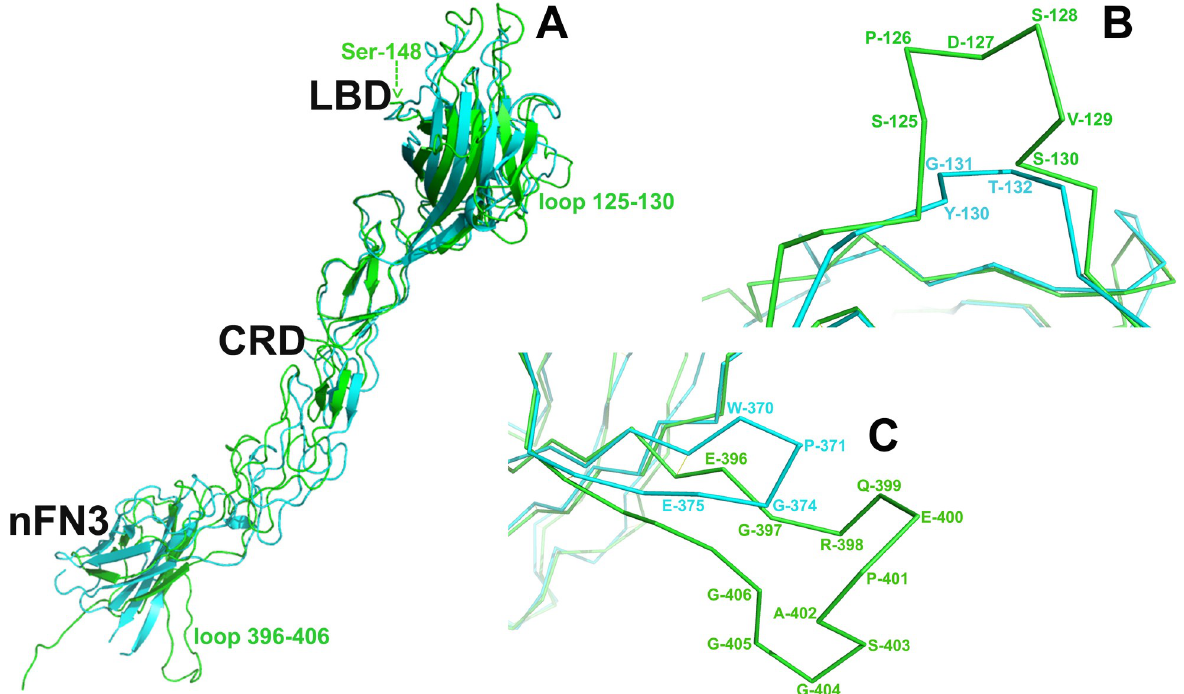
Fig 5. (A) Superimposition of the EphB6 and EphA2 ectodomains. The rmsd value between the C-alpha atoms is 3.803 Å . The EphB6-ECD is colored in green and the EphA2-ECD—in cyan. Arrow shows the location of Ser-148 preceding the ‘Super Serine’ loop (residues 151–161) that is not visible in our electron density map. LBD, ligand-binding domain; CRD, cysteine-rich domain; nFN3, N-terminal fibronectin 3 domain. (B) Close-up of the superimposed LBD H-I loop of the two molecules (EphB6 residues 125–130). (C) Close-up of the superimposed FN domain loop (EphB6 residues 396–406) of the two molecules.